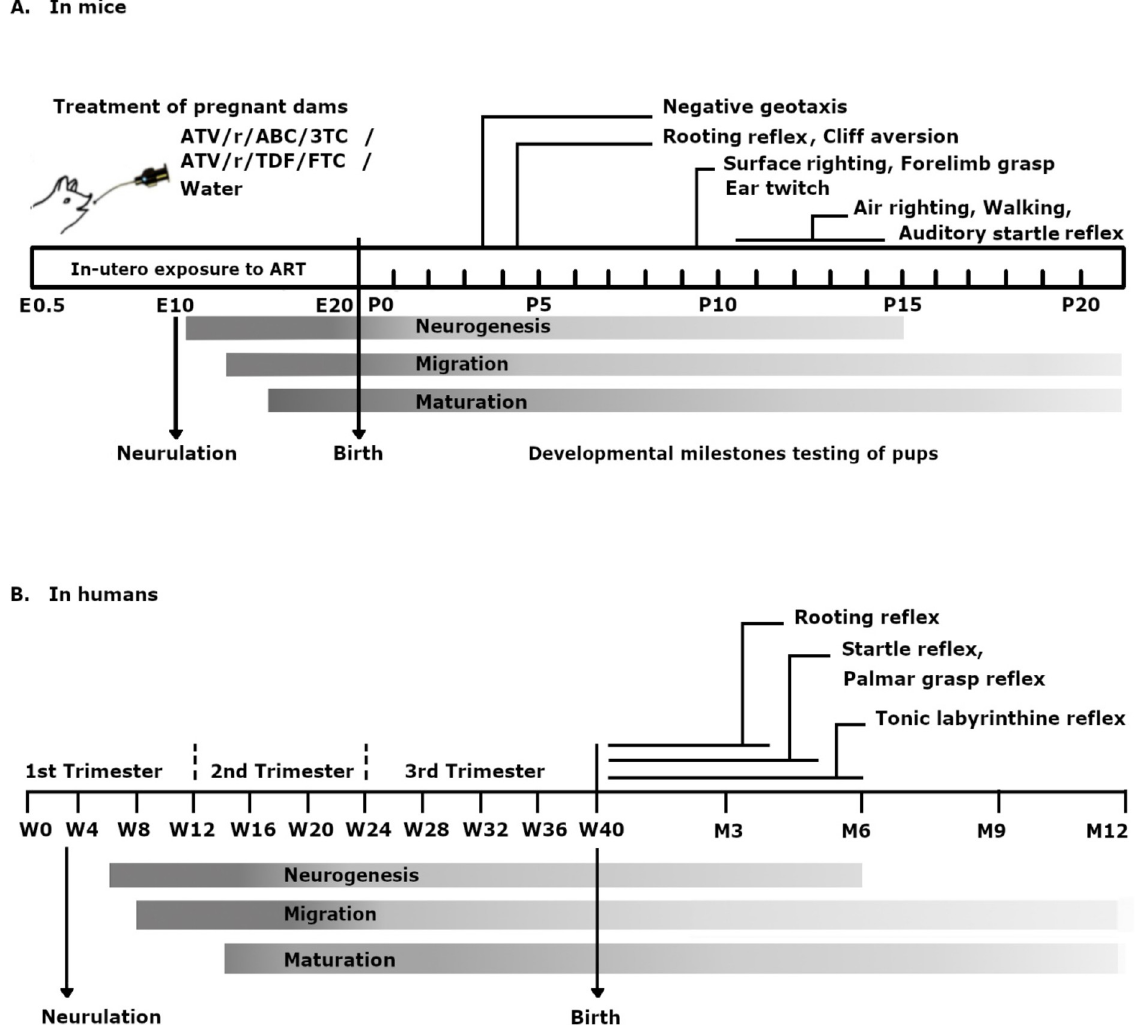
Fig 1. Comparative timelines of neurodevelopment and reflex maturation in mice and humans. Shown is the timeline for major neurodevelopmental events and reflex maturation in mice (A) and in humans (B) and a schematic representation for the experimental design in mice (A). Pregnant dams received ART from embryonic day 0.5 to E20 (till birth of pups). Developmental milestones were assessed in pups daily from P1 to P21. Being altricial in nature, a considerable amount of neurodevelopment occurs in mice pups postnatally. Timing of neurogenesis, maturation and migration of neuronal processes have been depicted using shaded rectangles for both species. Postnatal days on which mature responses are normally expected for specific reflex tests in mice have been shown with pointers in (A). Comparable reflexes in human infants and the timing for maturation and disappearance of these reflexes have been shown in